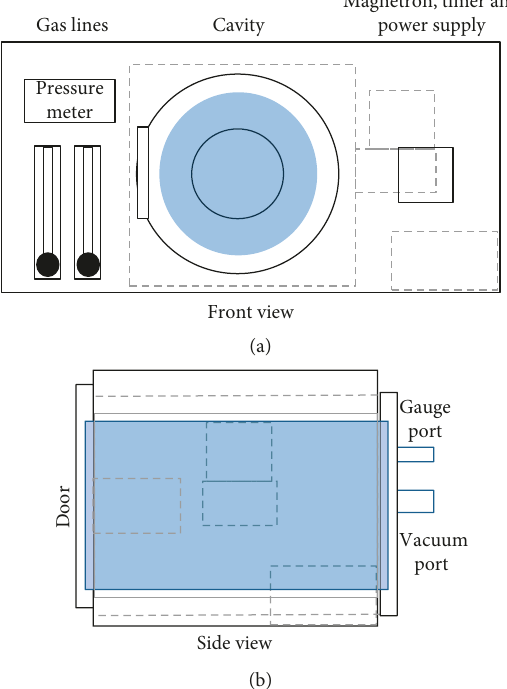
Figure 5: Typical front and side view schematic of the MRC plasma reactor chassis and cavity. Photograph of the microwave MRC-200 plasma